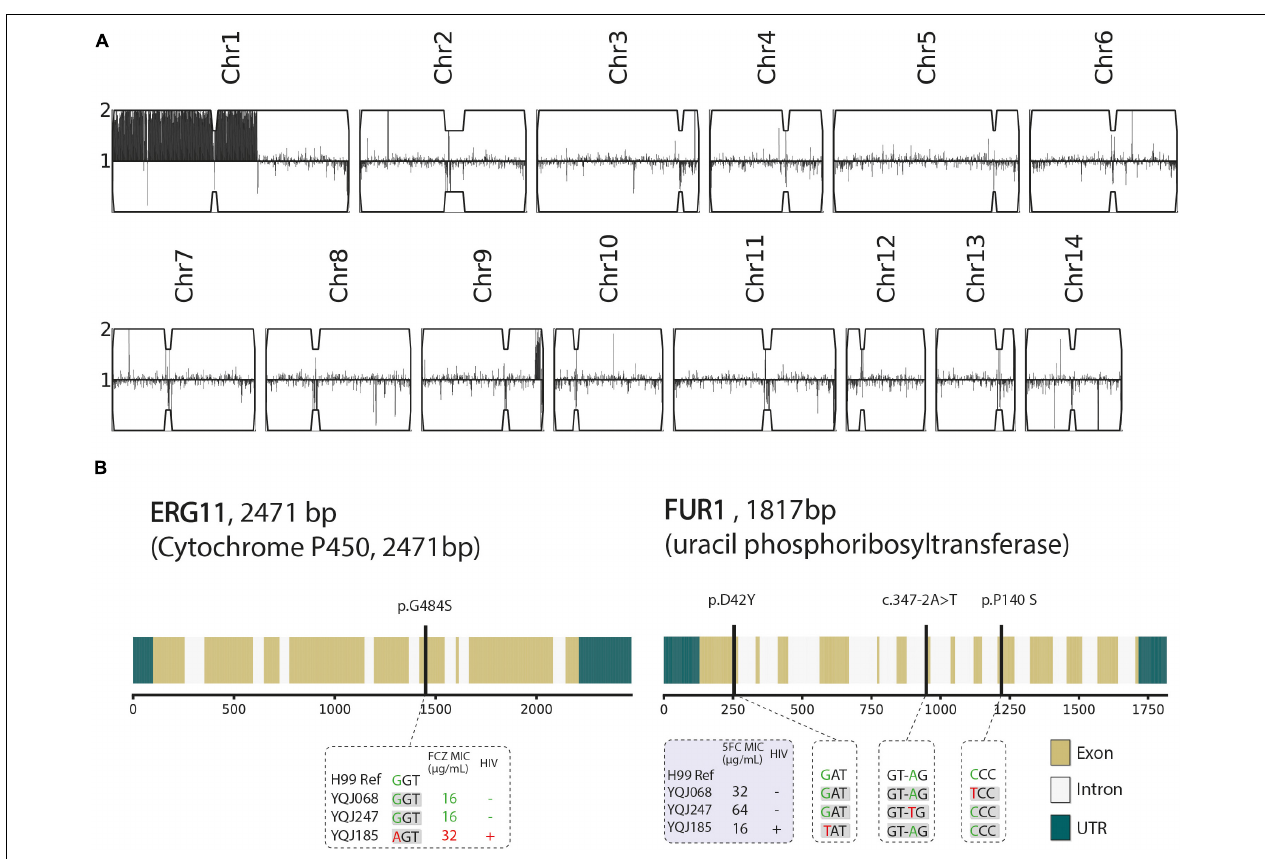
FIGURE 2 | Genetic characteristics of three resistant strains. (A) Karyotype of multidrug-resistant strain (YQJ185). Copy number is labeled in y -axis compared with haploid H99 reference using YMAP, with 1 copy number as baseline. Position of reads of each chromosome is on x -axis. (B) Non-synonymous mutation and splice site mutation of ERG11 and FUR1